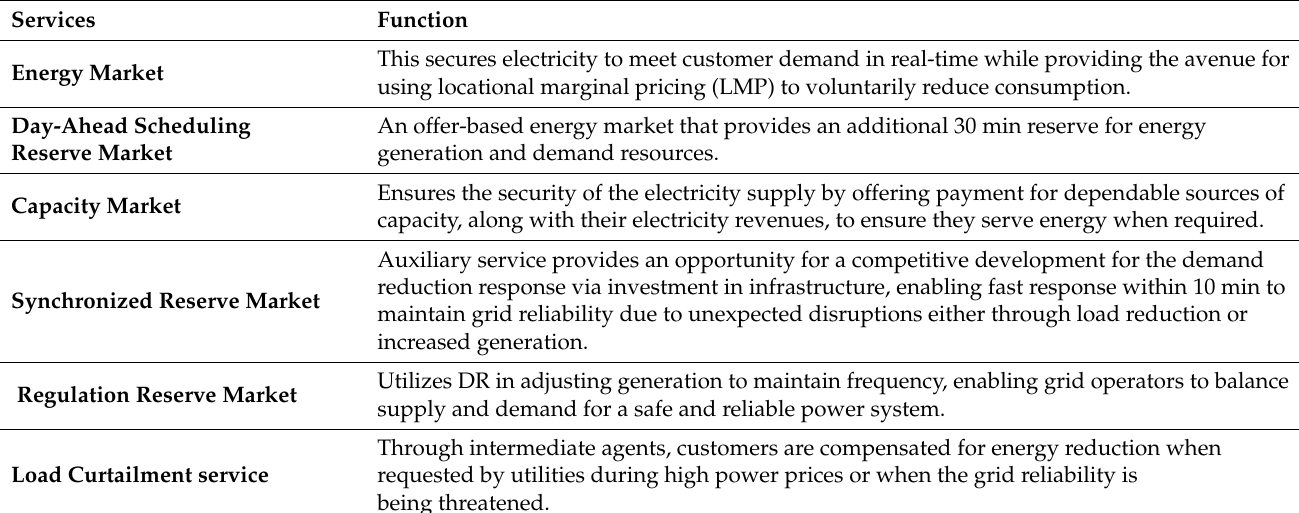
Table 1. Summary of the PJM and CAISO Electricity Market (NEM) mechanisms.